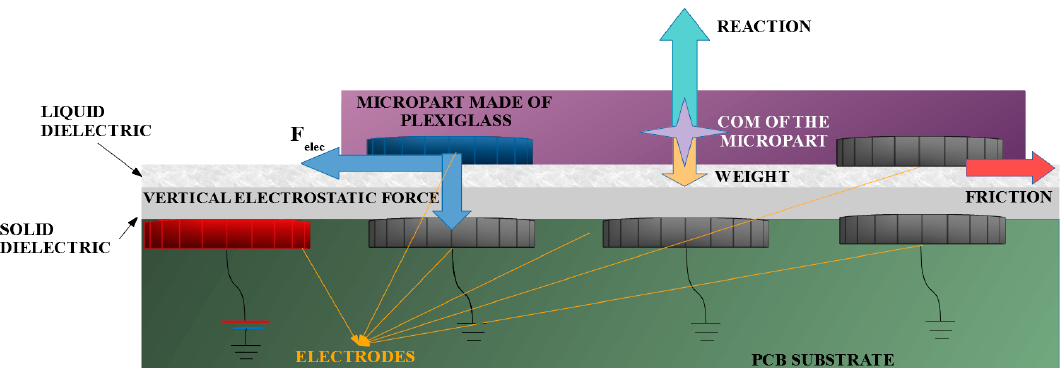
Figure 2. Shortcut of the “Smart Platform”.